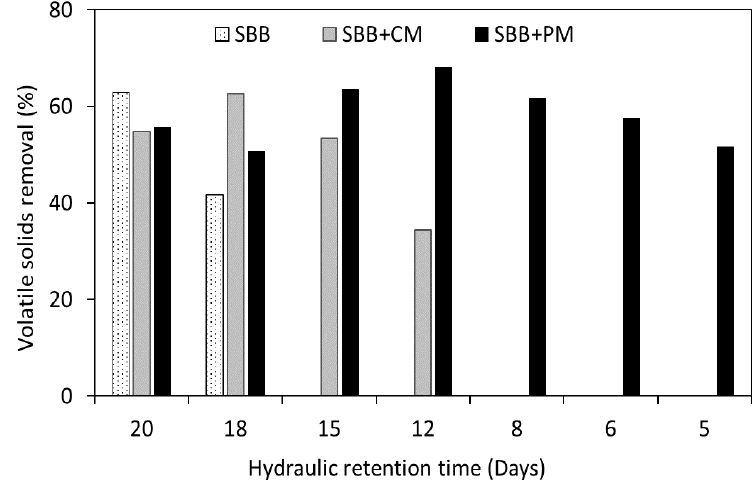
Figure 5. Volatile solids removal in the three semi-continuous reactors.